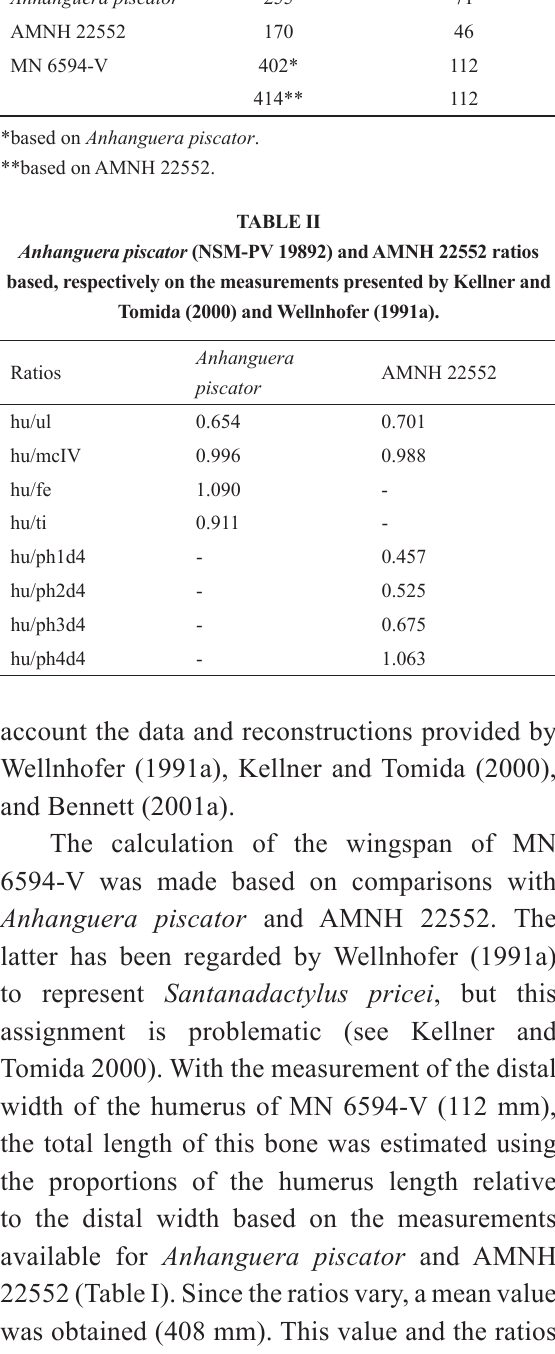
Measurements (in mm) of the humerus of Anhanguera piscator (NSM-PV 19892) and AMNH 22552, including the estimated humerus length for Tropeognathus cf. T. mesembrinus (MN 6594-V). Length Distal Width